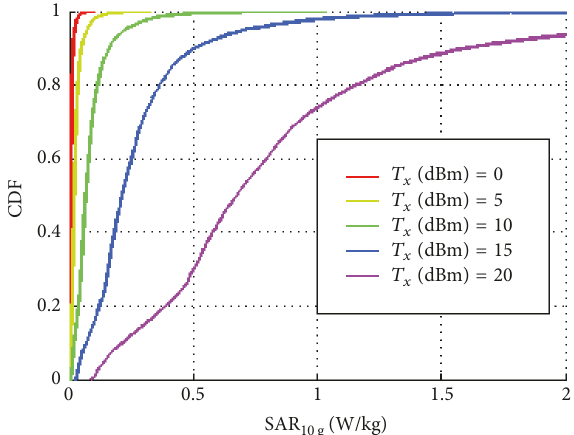
induced by the mobile phone at g